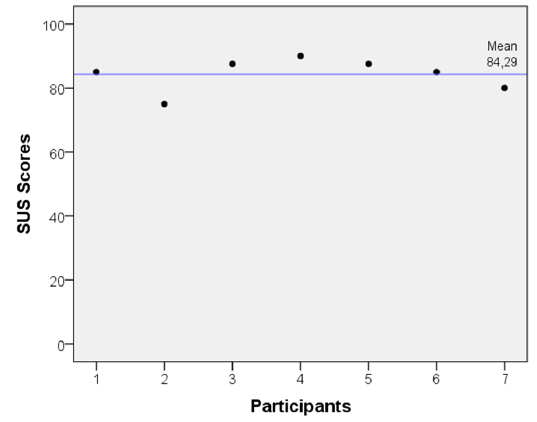
Figure 7. System Usability Scale (SUS) scores obtained from seven experts after using